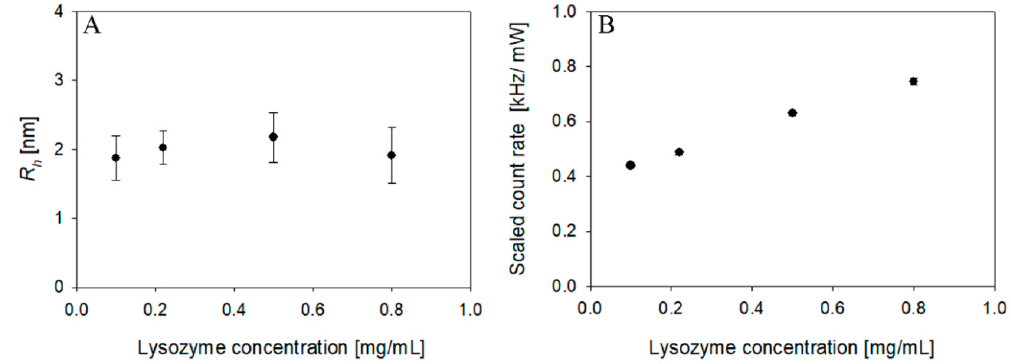
Figure 3. Hydrodynamic radius ( R h ) ( A ) and scaled count rate ( B ) of lysozyme at different concentration (100 mW laser intensity).